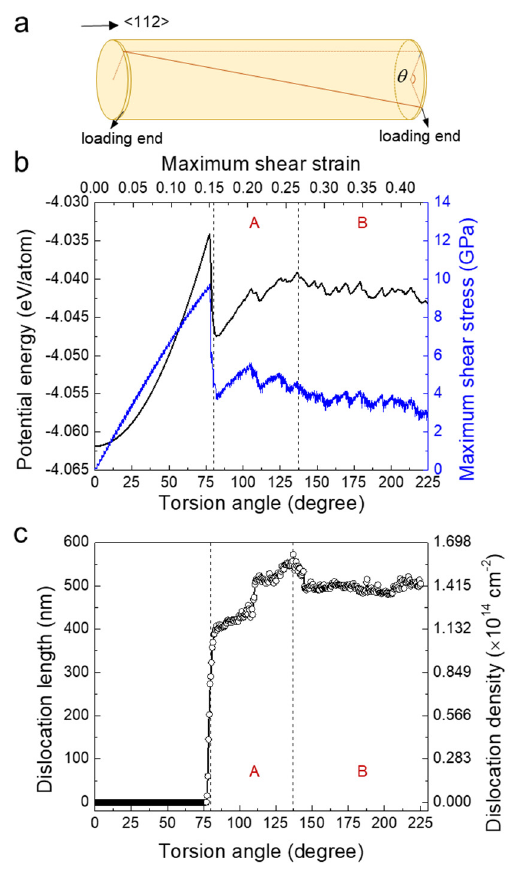
Figure 1. Torsion deformation of a pristine α -Fe nanowire with diameter of 10 nm and length of 45 nm at 1 K. ( a ). Schematic illustration of the twisting nanowire. ( b ) Evolution of maximum shear stress τ max (blue) and mean potential energy E p (black) with increase of torsion angle θ (maximum shear strain γ max ). ( c ). Evolution of the total dislocation length and the dislocation density with the torsion angle θ .